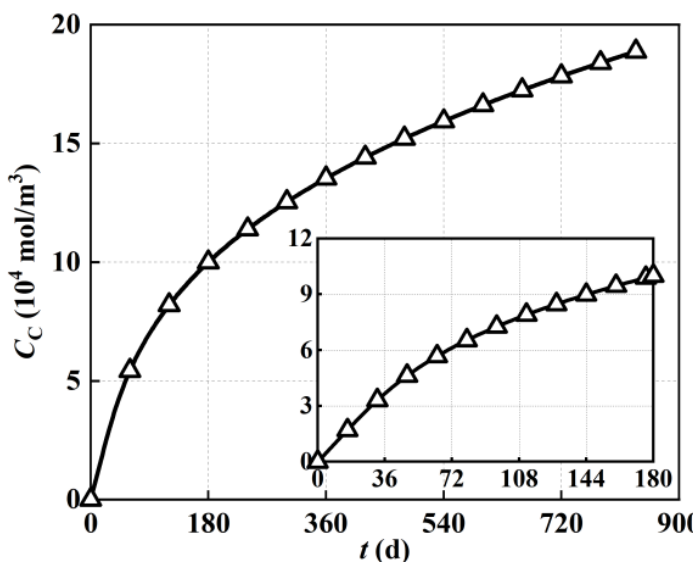
Figure 4. Variation in carbon deposition of porous anode electrode over operating time during 20,000 h of steady − state operation.